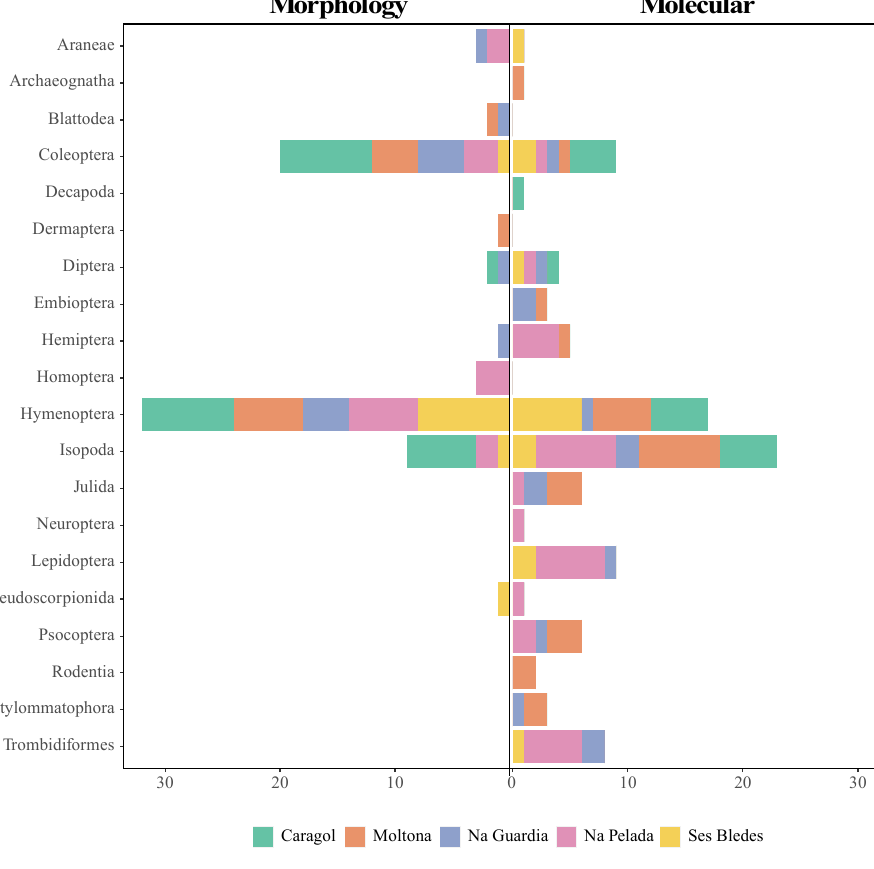
Figure 3. Percentage of occurrence of each family of animals or plants in the diet composition of Podarcis lilfordi through molecular analysis. All populations pooled. 3.2. Comparison of Morphological and Molecular Analytical Methods Comparisons were made, taking into account only ten randomly-selected morpho- logical molecular and molecular samples. Results are represented in Figure 2.